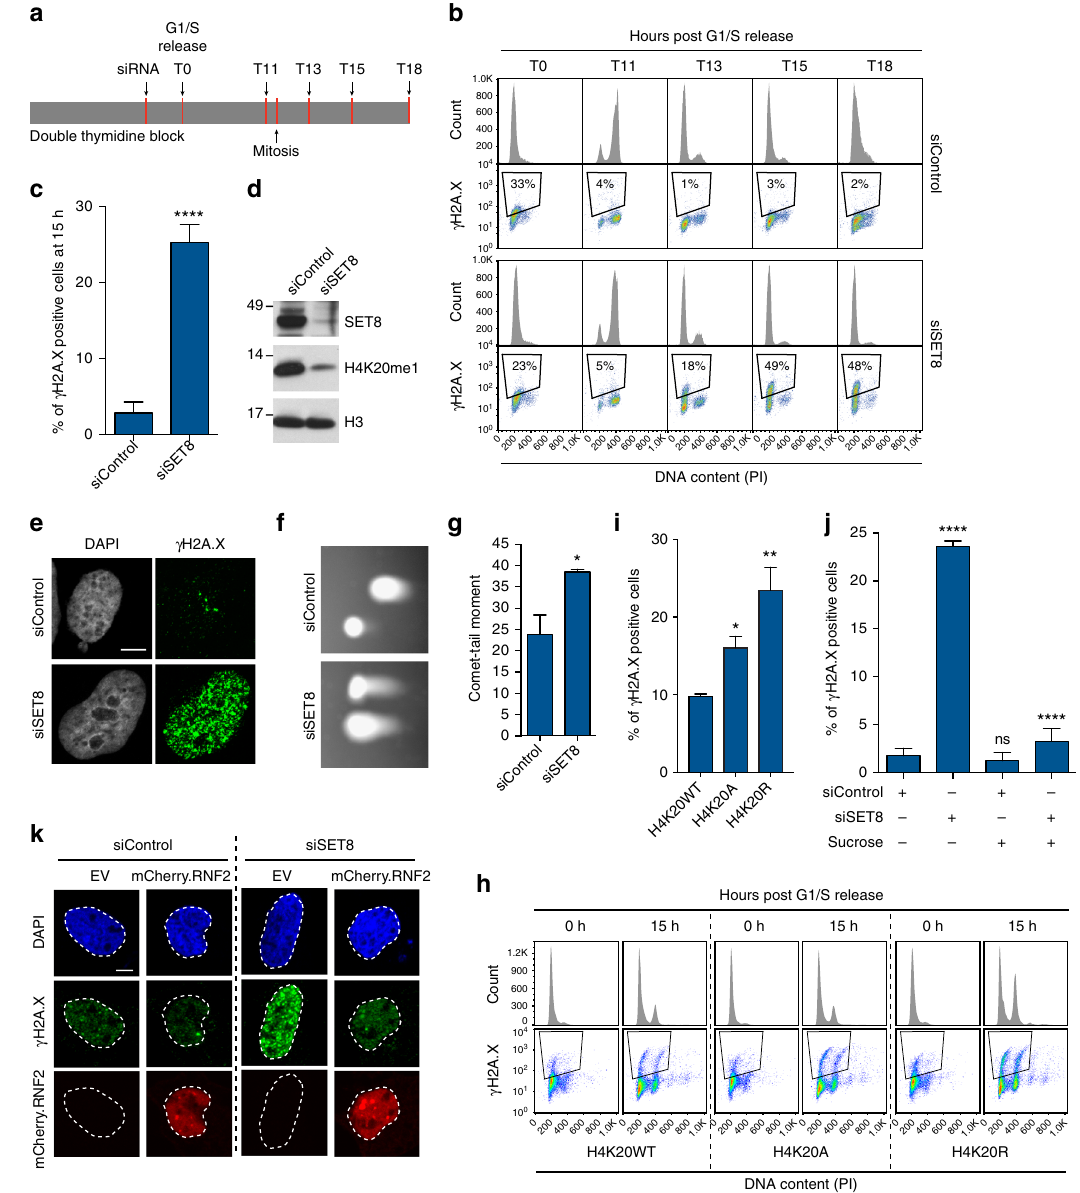
Fig. 2 Maintenance of ground-state chromatin compaction ensures genome integrity a Design of the experiment. U2OS cells synchronized by double thymidine block were transfected with Control and SET8 siRNA. Cells were released into thymidine-free medium and harvested at the indicated time points. b Cells from a were fi xed and stained with γ H2A.X antibody and PI followed by fl ow cytometric analysis. c Bars represent percentage of γ H2A.X- positive cells harvested at 15 h post G1/S release. Average± SD of fi ve independent experiments. **** p < 0.0001 (unpaired t test). n > 20,000 in each experiment. d U2OS cells synchronized as in a were harvested at 15 h post G1/S release and immunoblotted with the indicated antibodies. e U2OS cells synchronized and siRNA transfected as in a were fi xed at 15 h post G1/S release and stained with DAPI and γ H2A.X antibody. (Bar, 10 µ m). f U2OS cells synchronized and siRNA transfected as in a were prepared for single-cell electrophoresis in neutral electrophoresis buffer at 15 h post G1/S release. g Relative comet-tail moments from experiments in f plotted as means ± S.E.M. * p < 0.05 (unpaired t test). n > 55. h U2OS cells expressing Dox-inducible FLAG-HA-tagged histone H4-wild type (H4K20WT) or histone H4 lysine 20 to alanine or arginine (H4K20A/R) mutant were synchronized with double thymidine block. Cells were fi xed at 15 h post G1/S release and stained with γ H2A.X antibody and PI followed by fl ow cytometric analysis. i Bars represent percentage of γ H2A.X-positive cells from h. Average ± SD of three independent experiments. * p < 0.05, ** p < 0.01 (ANOVA). n > 20,000 in each experiment. j U2OS cells synchronized and siRNA transfected as in a were mock and sucrose treated (125mM) at 12 h post G1/S release and were fi xed at 15 h post G1/S release. Bars represent percentage of γ H2A.X-positive cells in the indicated samples (average ± SD of three independent experiments). **** p < 0.0001 (unpaired t test). n > 20,000 in each experiment. k U2OS cells were transfected with mCherry-tagged human RNF2 (RING1b) and